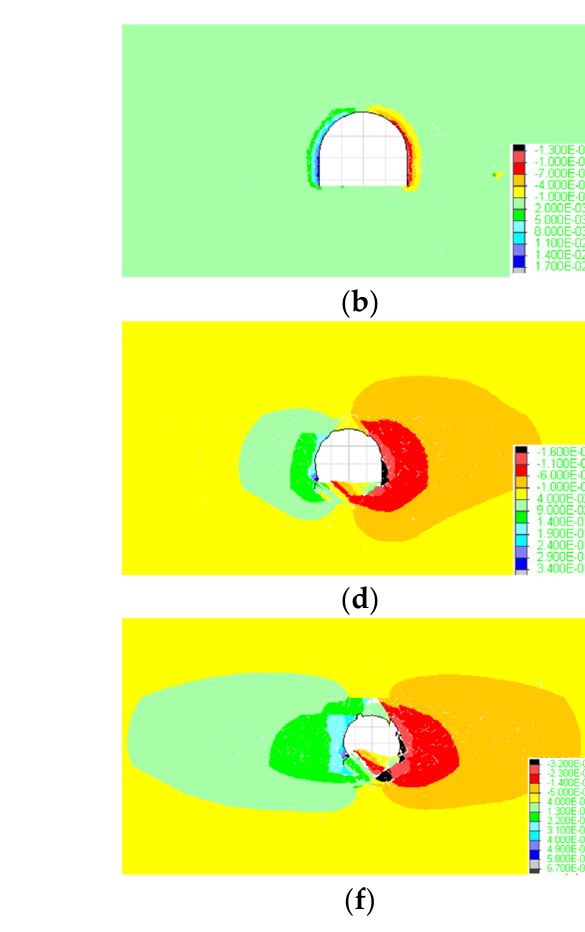
Figure 10. Horizontal displacement nephograms of roadway on different days. ( a ) 1st d; ( b ) 5th d; ( c ) 50th d; ( d ) 200th d; ( e ) 250th d; ( f ) 300th